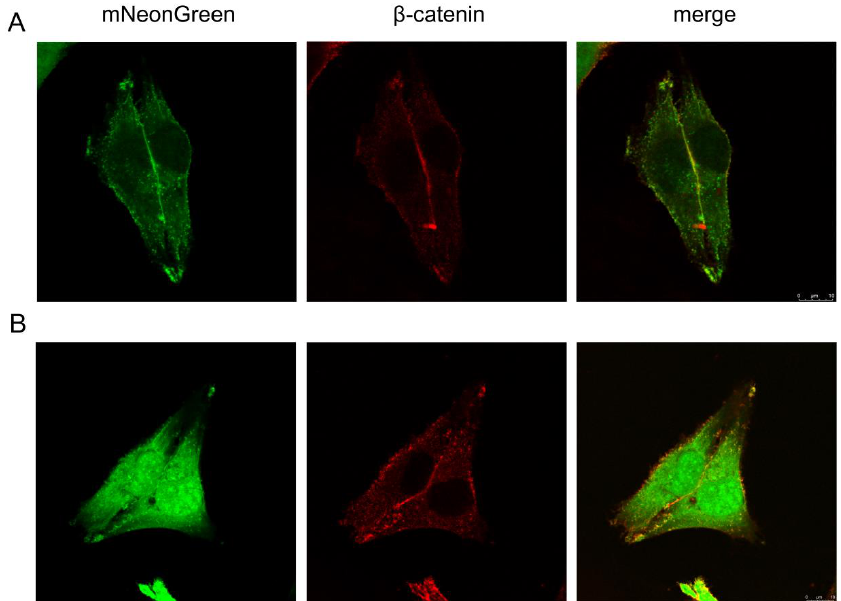
Figure 1. Palmitoylated mNeonGreen (palmNG) partially localizes to cellular membranes. MJSpalmNG cells were fixed, permeabilized, and stained with anti-β-catenin antibody, followed by AlexaFluor 546-conjugated IgG. The colocalization of palmNG and β-catenin was analyzed using fluorescent confocal microscopy. ( A ) and ( B ) show representative images of two different palmNG localization patterns in MJSpalmNG cells.